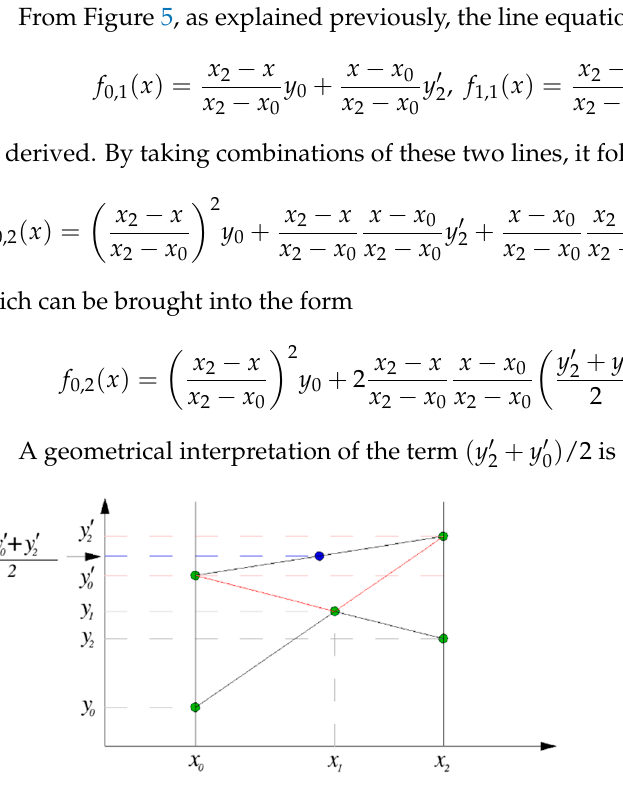
Figure 6. Geometrical interpretation of the term